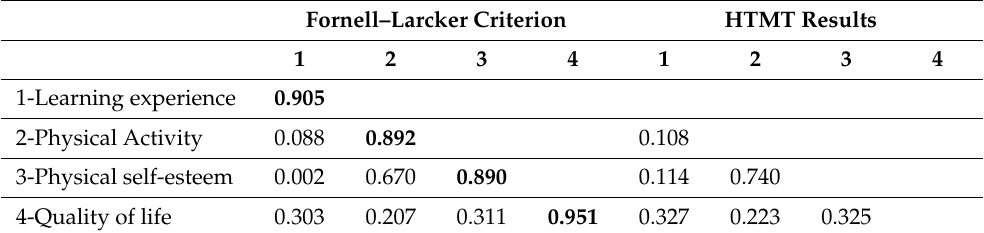
Table 4. Fornell–Larker Criterion and HTMT results.